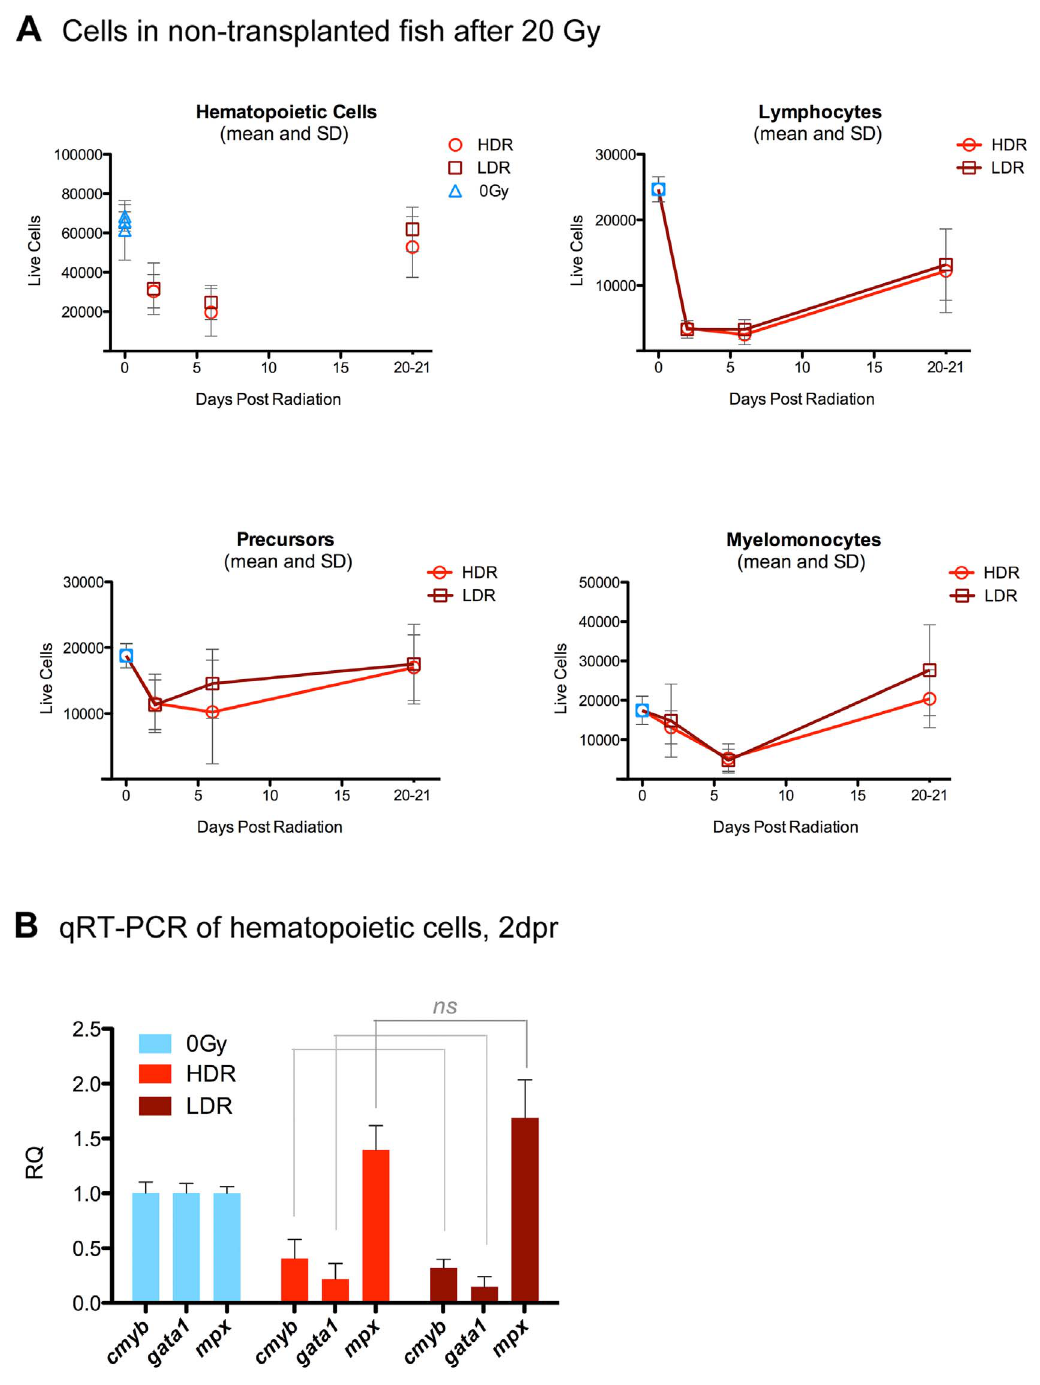
Figure 2. Myelosuppression after 20Gy at 25 cGy/min vs 800cGy/min in non-transplanted fish. A, Flow cytometry analysis of hematopoietic cell recovery in the kidney on days 2, 6, and 20–21 following radiation at either 25cGy/min (LDR) or 800cGy/min (HDR), showing initial myelosuppression followed by hematopoietic recovery. Plot shows the means and SDs of pooled data from two independent biological trials, for a total of at least 7–10 fish per data point. 100,000 events were collected per sample. No significant differences were noted between dose-rate groups. B, qRT-PCR of hematopoietic cells 2 days post radiation. Data shows pooled results from two independent biological trials; each trial composed of 4 fish per group. No statistically significant differences between dose-rate groups were noted. RQ: Relative Quantitation. a biomarker of radiation response [28,29]. Although zebrafish were found between the two dose-rate groups before and up to one hematopoietic cell samples showed radiation-induced changes in day after radiation. While p53 was found to be significantly up- expression levels following radiation, no significant differences regulated in LDR hematopoietic cells 2 days after radiation, the